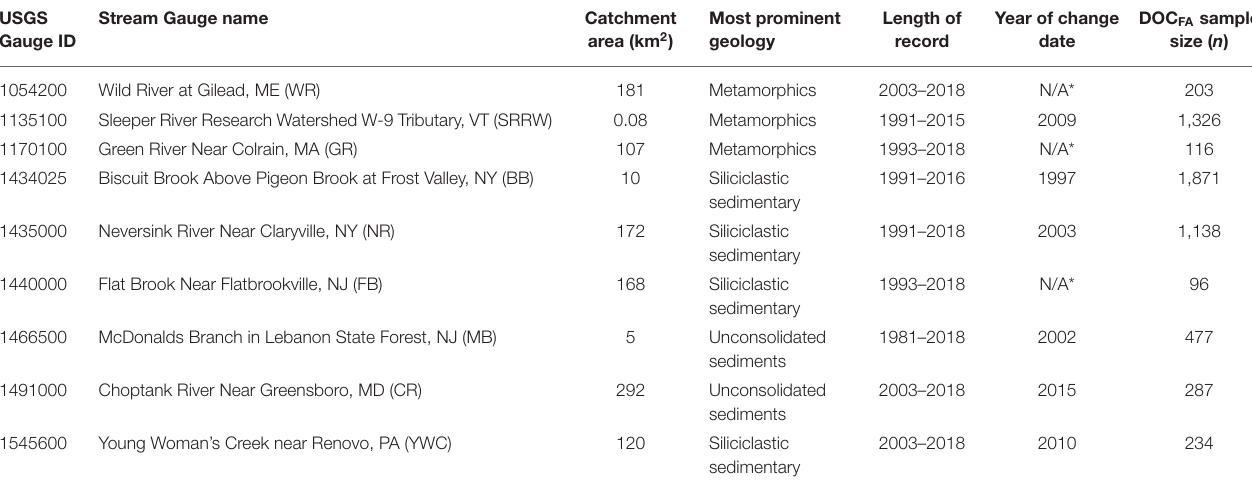
TABLE 1 | Northeastern catchment attributes, length of DOC FA records and calculated change dates.